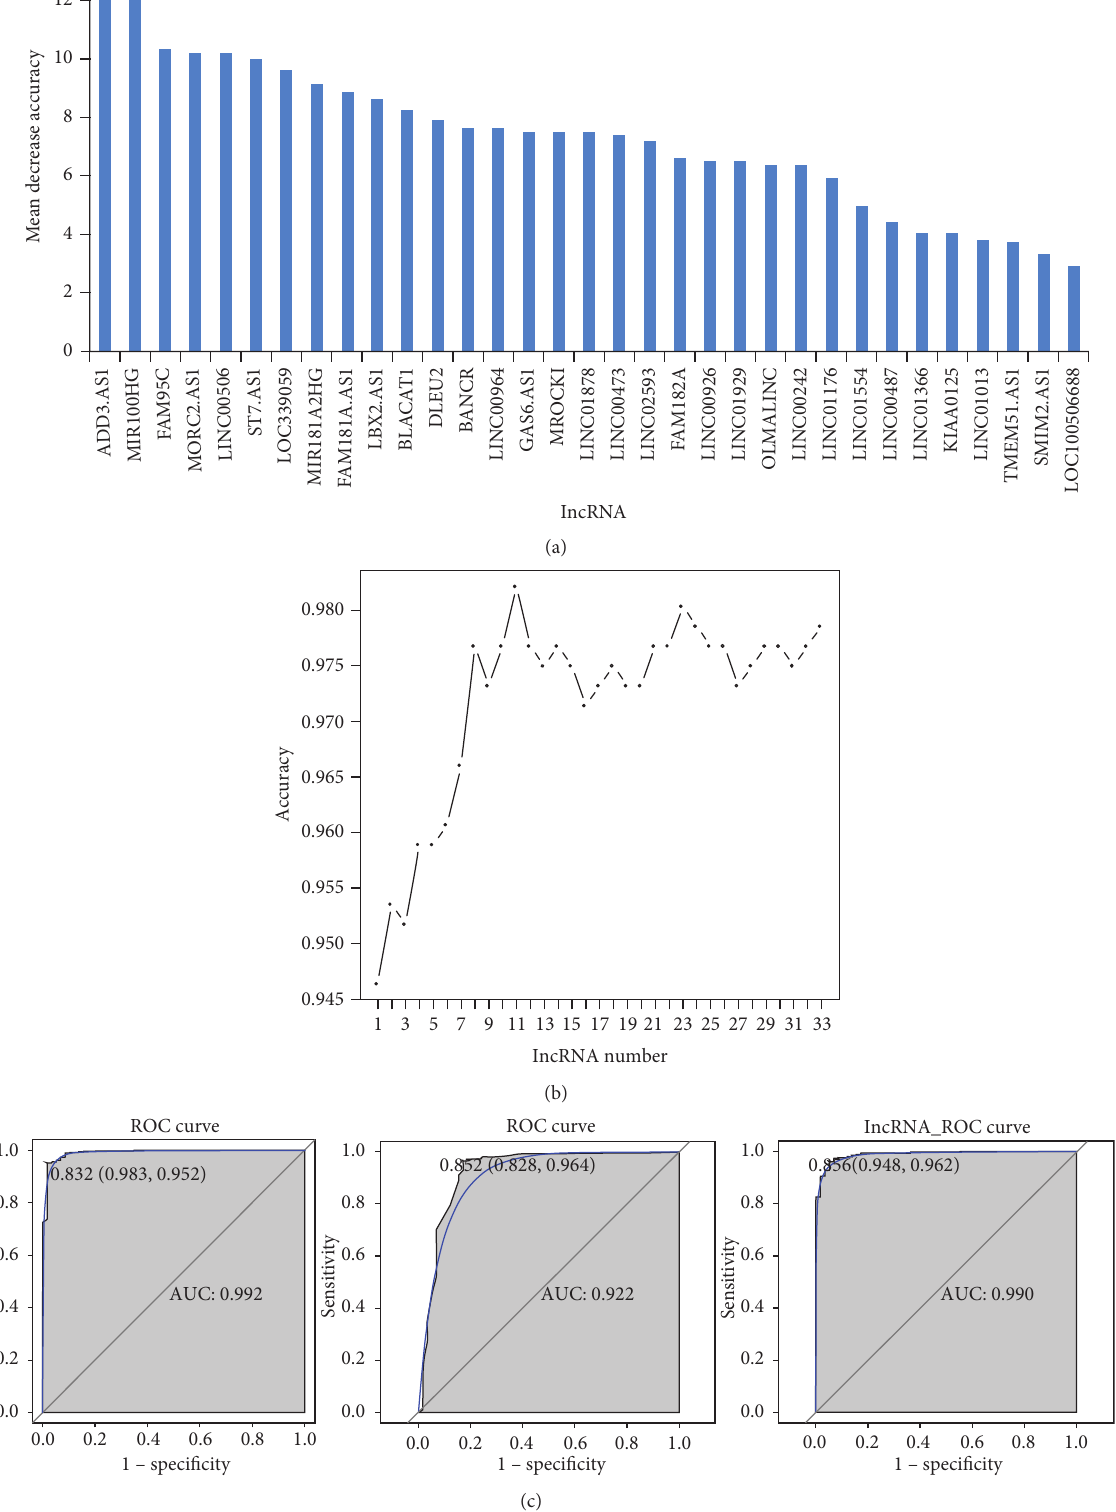
Figure 2: Identification of optimal diagnostic lncRNAs biomarkers for PTC based on RF, DT, and SVM classification models. (a) The ranking of all lncRNAs. lncRNAs were ranked according to the standardized drop in prediction accuracy. (b) The tendency chart of AUC along with the increase of lncRNAs. (c) ROC results of combinations of 11 optimal diagnostic lncRNAs